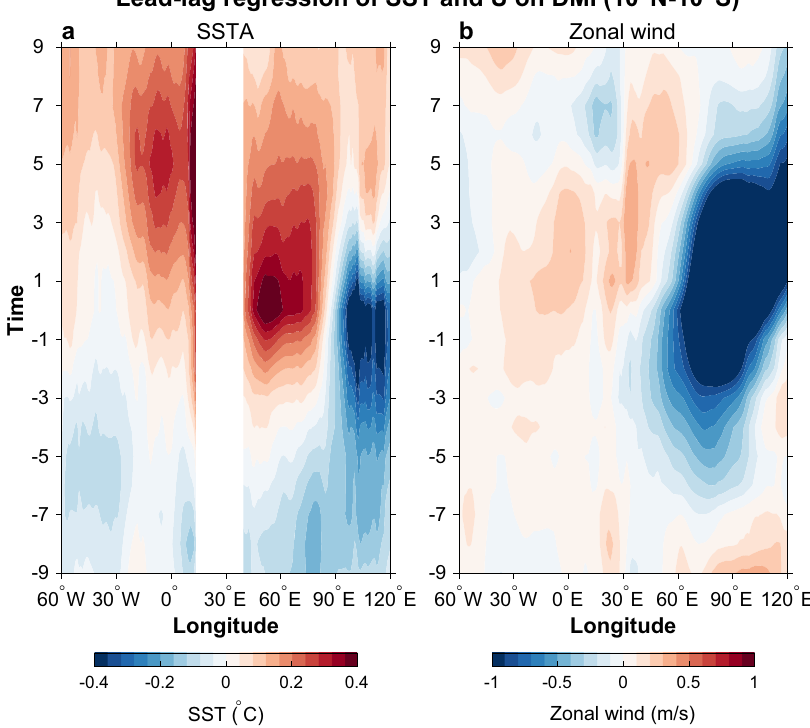
Fig. 2 Hovmöller diagrams showing evolutions of sea surface temperature (SST) and zonal wind anomalies associated with positive IOD. Lead-lag regression of ( a ) SST (°C °C − 1 ) and ( b ) 850 hPa zonal wind anomalies (m s − 1 °C − 1 ) on the Dipole Model Index (DMI) averaged between 10°N – 10°S. Y-axis represents the leading time, with negative representing months prior to Indian Ocean Dipole (IOD) peak and positive for after IOD